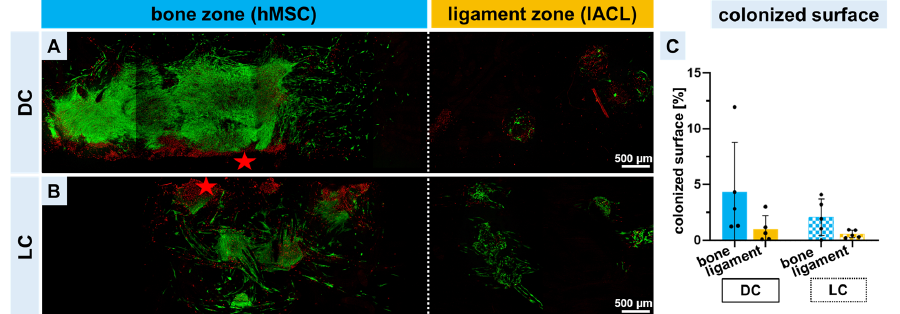
Figure 3. Vitality assay of spheroid-colonized scaffolds after 14 days. Viable and dead human mesenchymal stem cell (hMSC) and lapine anterior cruciate ligamentocyte (lACL) spheroids, which were directly placed on the scaffold zones immediately after the 2 days of spheroid assembly ( A , DC) or with spheroids pre-cultured for 14 days ( B , long-time: LC) before being seeded on the scaffold bone or ligament zones after 14 days of scaffold cultivation. Scale bars of 500 µ m. The calculation of the colonized surface was based on the viability pictures ( C ). Five independent experiments analyzed with ROUT (1%) outlier test and one-way ANOVA showed no significant differences. The red stars show the lower third of the scaffold where the transsection was performed.